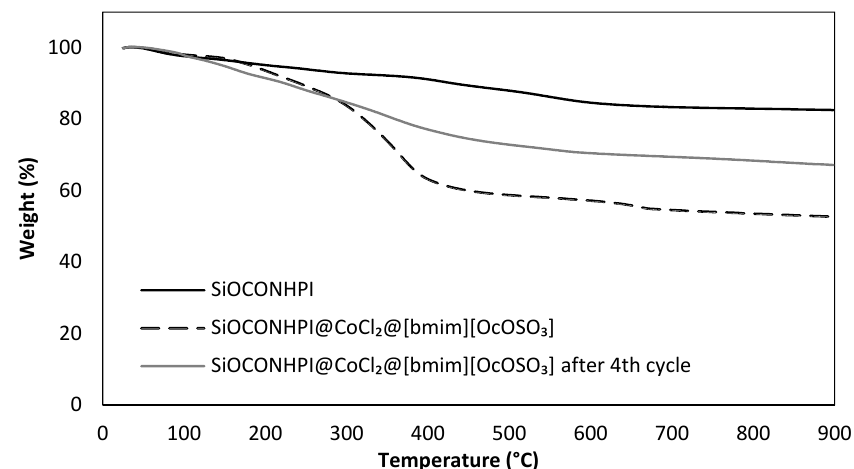
Figure 8. TGA curves obtained for SiOCONHPI, SiOCONHPI@CoCl 2 @[bmim][OcOSO 3 ] and SiOCONHPI@CoCl 2 @[bmim][OcOSO 3 ] after the fourth cycle.